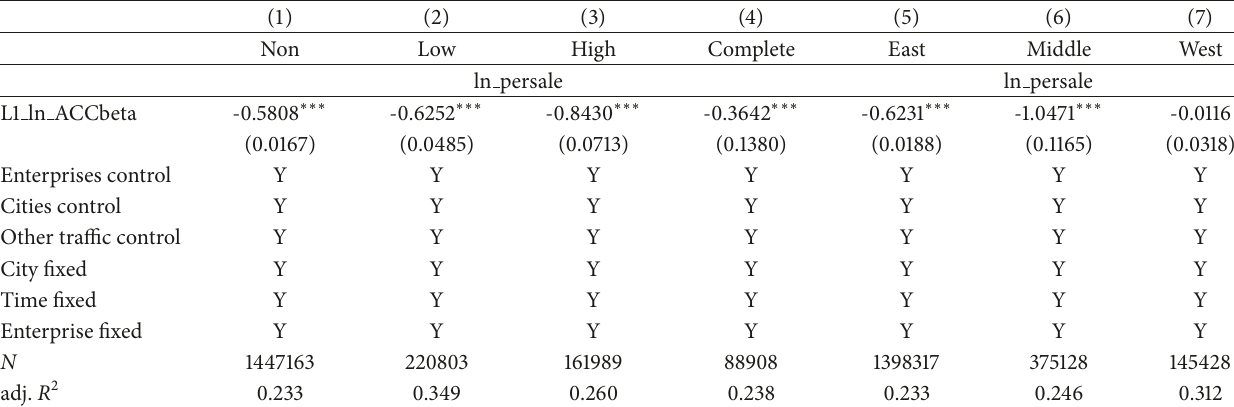
Table 15: Regression results of different export shares and regionals in peripheral